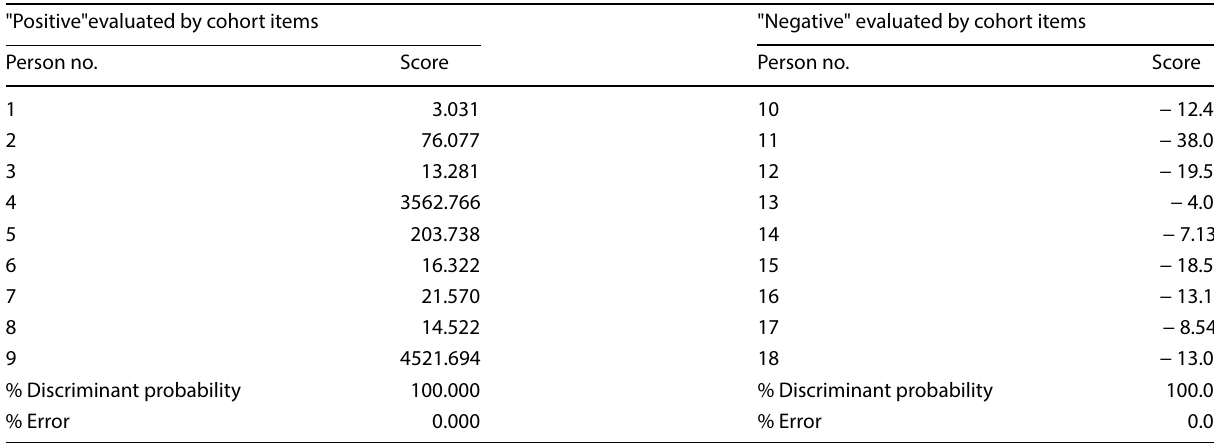
Discriminant scores were calculated using the formula in